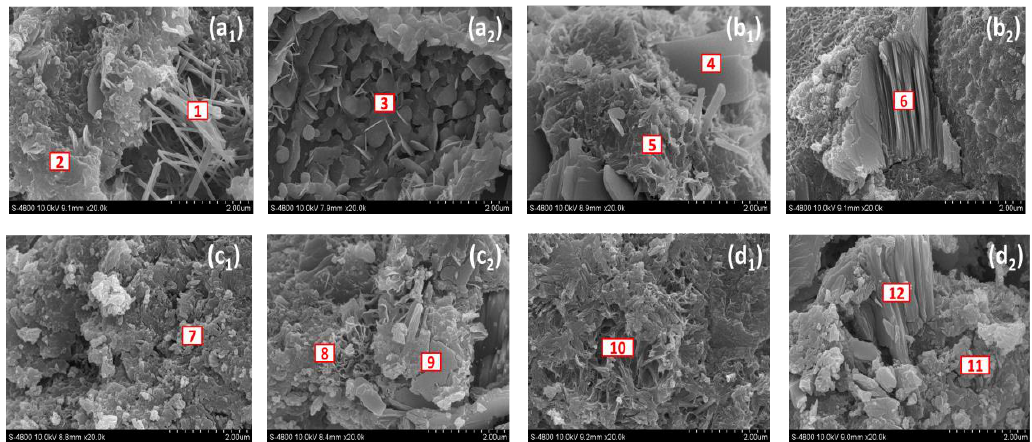
Figure 6. Microstructures of MBER and N-MBER in amplification factor of 20,000. ( a 1 , a 2 ) MBER after 3 days; ( b 1 , b 2 ) MBER after 28 days; ( c 1 , c 2 ) N-MBER after 3 days; ( d 1 , d 2 ) N-MBER after 28 days. Table 6. Energy spectrum analysis results of MBER and N-MBER.